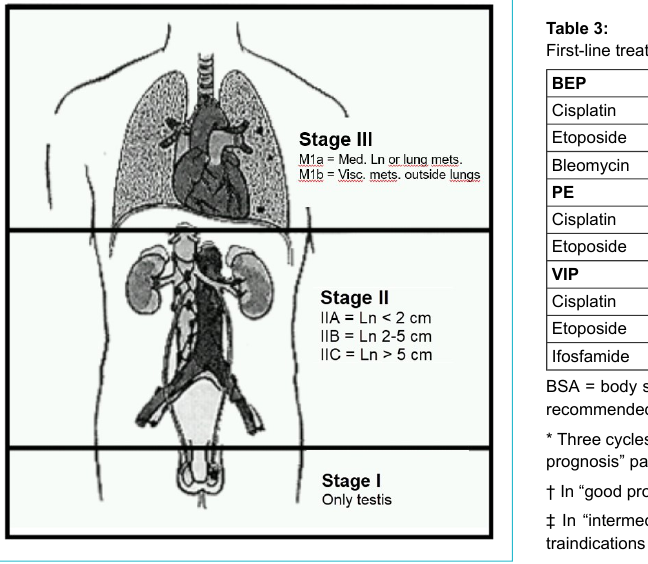
Figure 1: Anatomical Staging of testis cancer. Ln = lymp hnodes; Med. = mediastinal; Mets. = metastases; Visc. = visceral